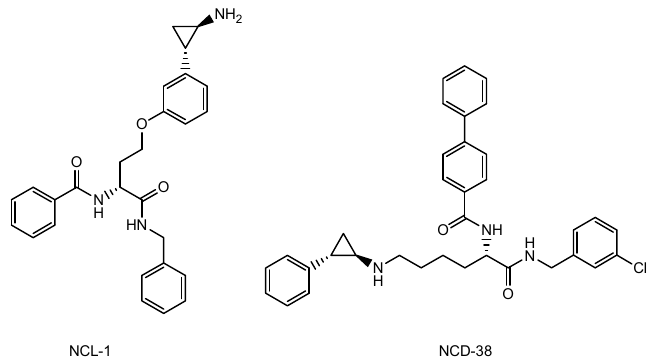
Figure 9. The structures of low-molecular drugs that are potential vascular endothelial growth factor (VEGF) inhibitors.